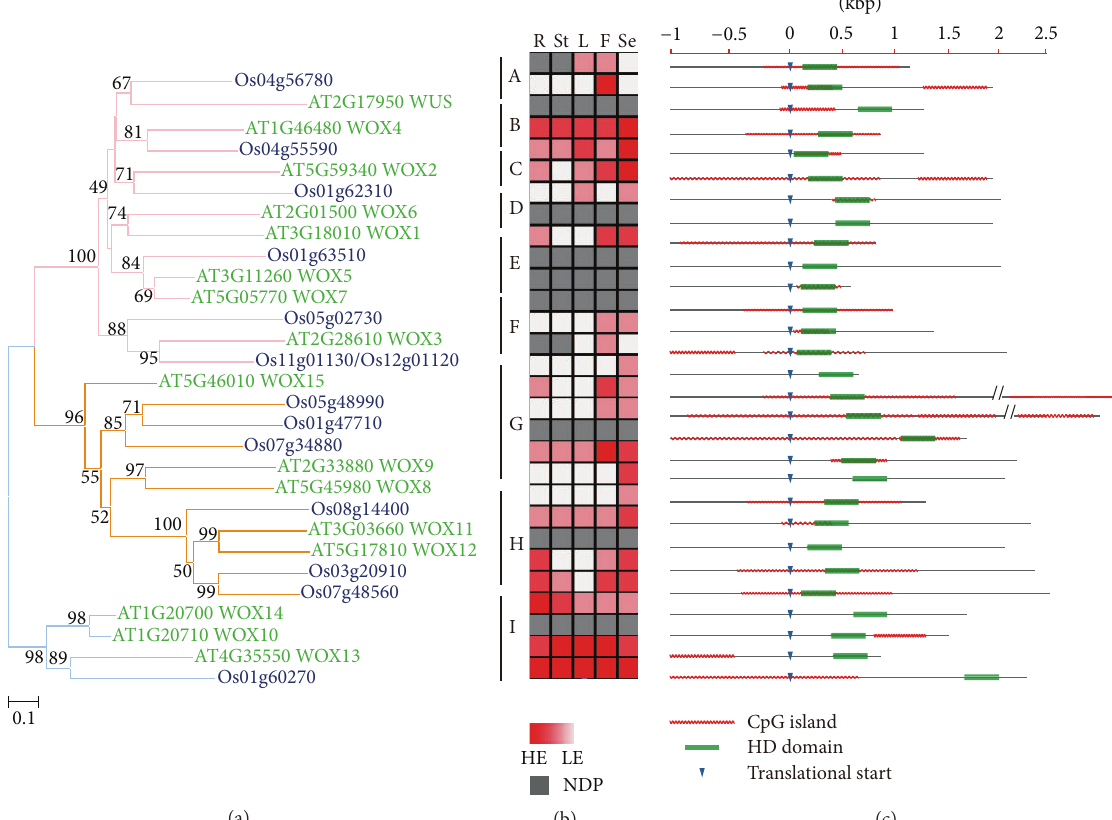
Figure 8: Phylogenetic and expression analysis of WOX family in Arabidopsis and rice. (a) The phylogenetic tree (NJ) of 29 WOX members from Arabidopsis and rice constructed by MAGE 4 (Kumar et al., 2004). A, B, C, D, E, F, G, H, and I refer to subgroups WUS, WOX4, WOX2, WOX1/6, WOX5/7, WOX3, WOX8/9, WOX11/12, and WOX13, respectively. (b) Expression pattern analysis; the average values were chosen among the expression values published in AtGenExpress. (http://www.weigelworld.org/resources/microarray/AtGenExpress), SIGnAL (http://signal.salk.edu/), and RiceXPro (http://ricexpro.dna.affrc.go.jp). R: root; St: stem; L: leaf; F: flower; Se: seed; HE: high expression; LE: low expression; NDP: no data published. (c) The CpG islands among the members are highlighted in red